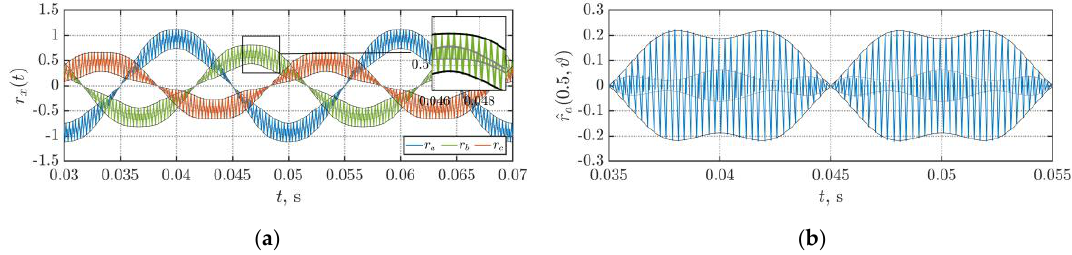
Figure 9. Primary (black) and secondary (gray) envelopes in case of THIPWM1/4 at m = 0.5 and f sw =